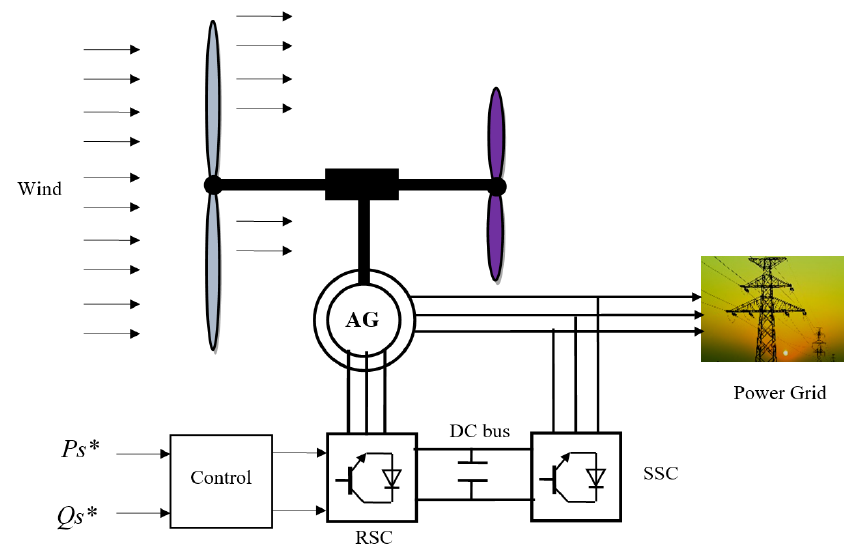
Figure 2. Structure of MRWTS.